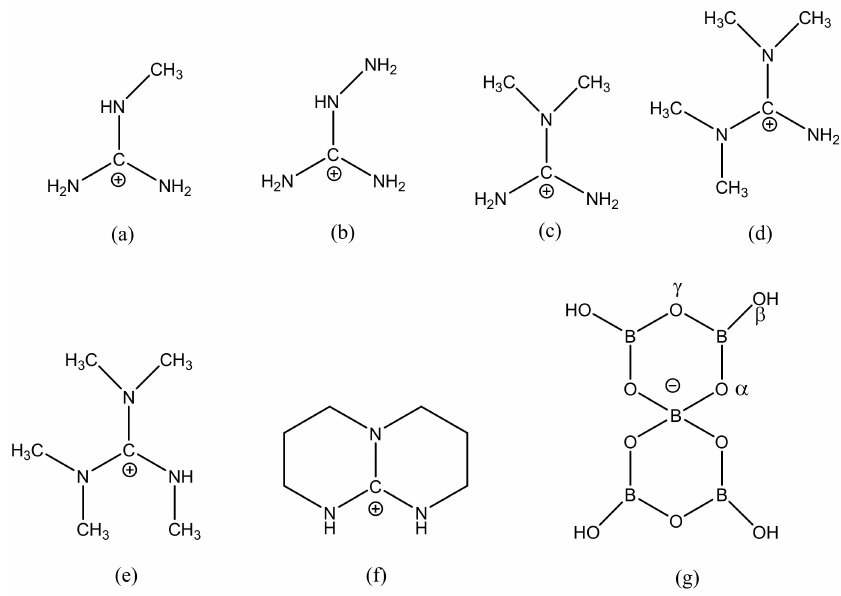
Figure 1. Schematic drawings of the cations and anions found in compounds 1 – 6 : ( a ) N -methyl guanidinium(+1) in 1 ; ( b ) N -aminoguanidinium(+1) in 2 ; ( c ) N , N -dimethylguanidinium(+1) in 3 ; ( d ) N , N , N (cid:48) , N (cid:48) -tetramethylguanidinium(1+) in 4 ; ( e ) N , N , N (cid:48) , N (cid:48) , N ”-pentamethylguanidinium(1+) in 5 ; ( f ) TBDH (TBD = 1,5,7-triazabicyclo[4.4.0]dec-5-ene) in 6 ; ( g ) tetrahydroxidohexaoxidopentaborate(1-) found in compounds 1 – 6 with H-bond acceptor sites labelled as α , β , or γ